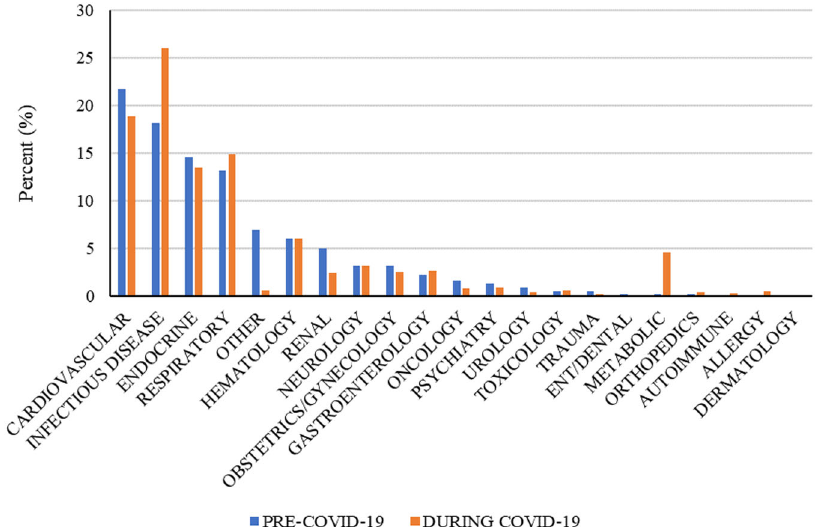
Fig. 2 During COVID-19, the infectious disease and metabolic categories experienced the greatest percentage increase in healthcare professional attitudes towards using POCTs to diagnose